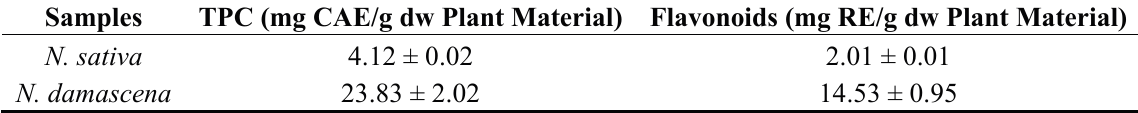
Table 2. The total phenolic and flavonoids